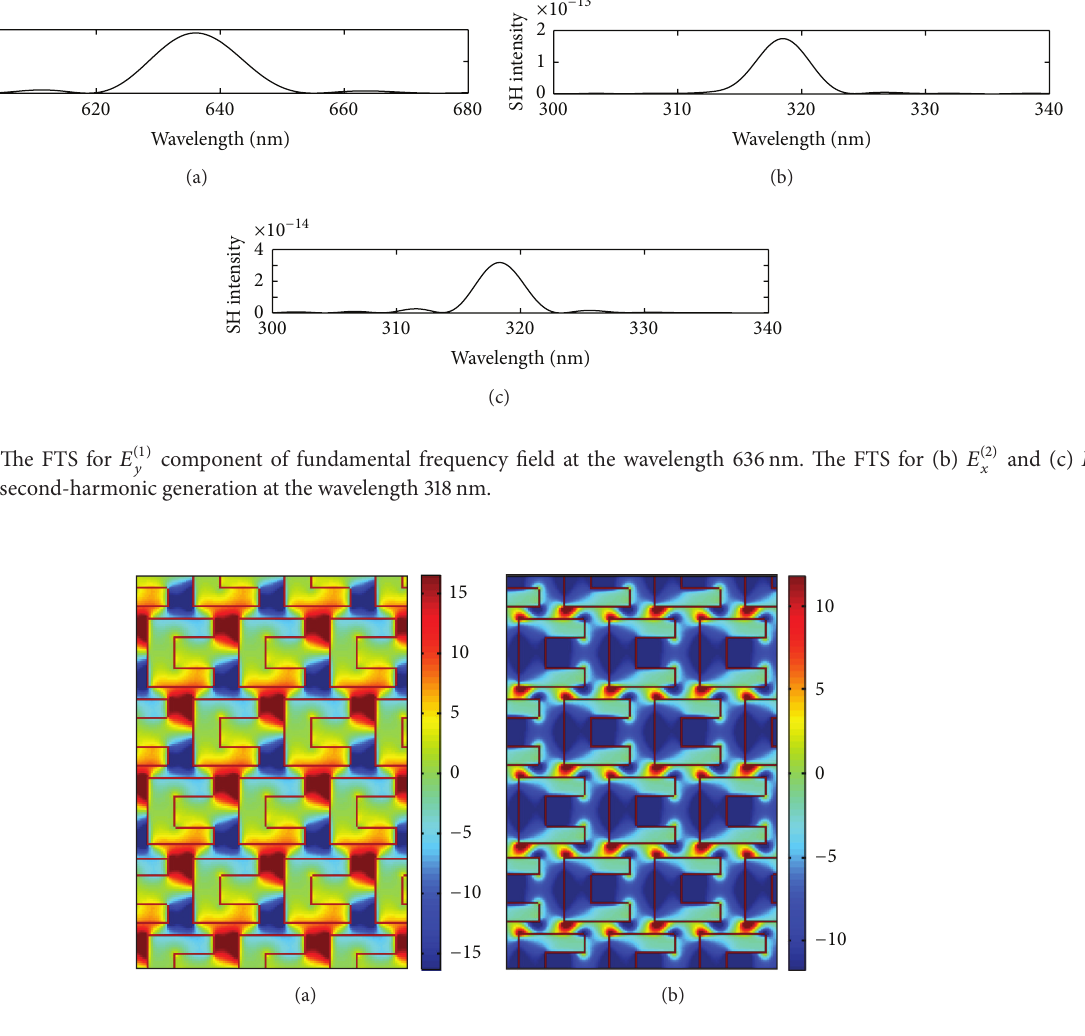
Figure 4: The electric field (a) 𝐸 (1) 𝑥 and (b) 𝐸 (1) 𝑦 distribution of fundamental frequency above the gold film region at wavelength 636 nm,